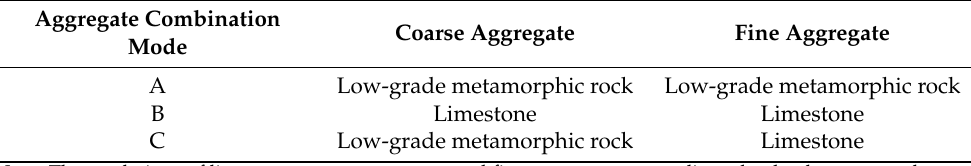
Table 6. Aggregate combination mode in LMR-CSPB.